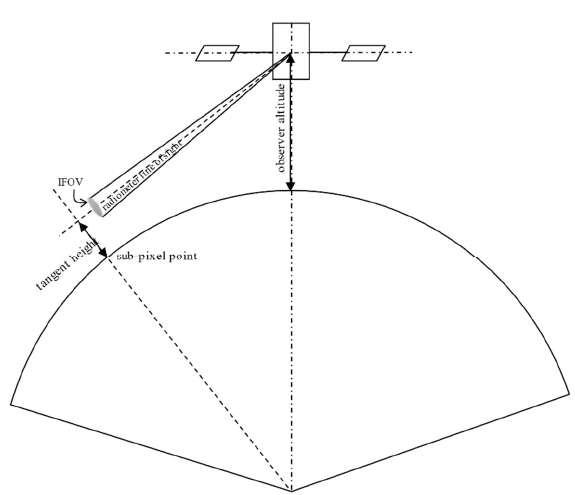
Figure 2. Definition of tangent height for atmosphere modeling. Sensors 2019 , 19 , x FOR PEER REVIEW